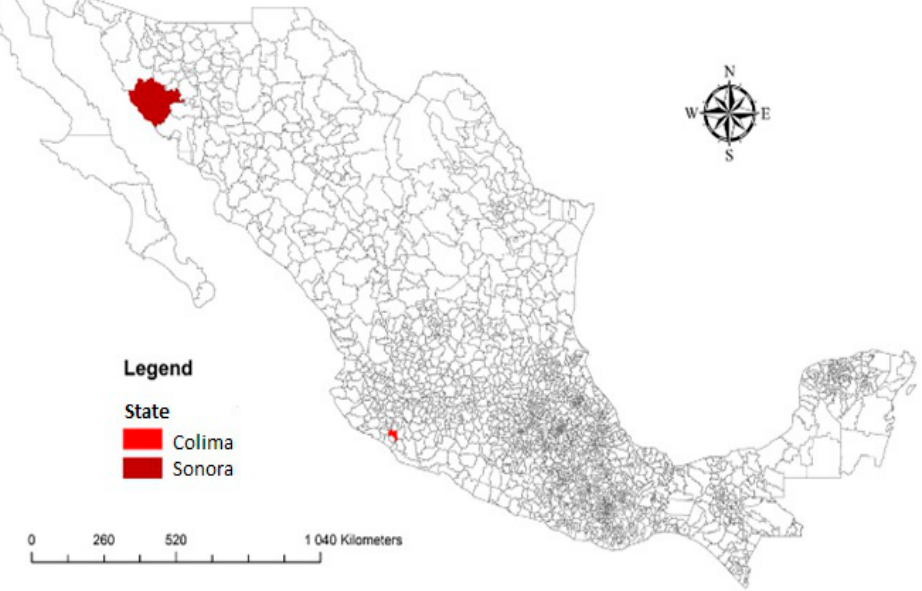
Figure 1. Map of Mexico showing locations of Colima and